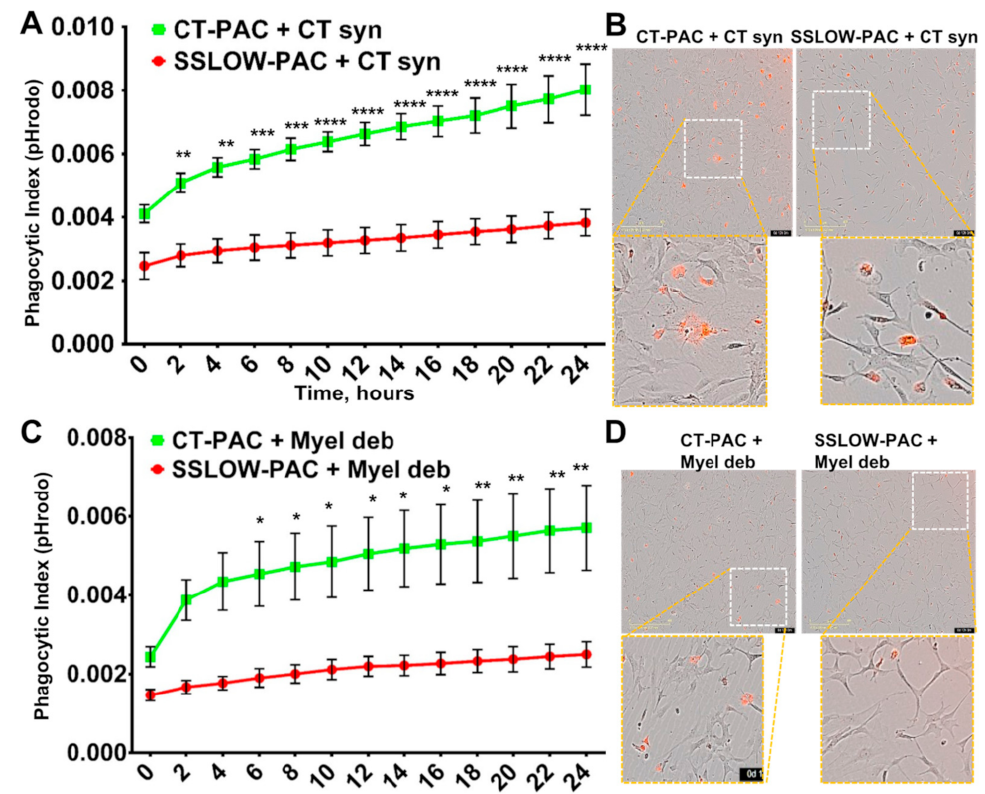
Figure 7. Live-cell imaging of phagocytic activity of PACs from SSLOW-infected mice. ( A ) Real-time, live-cell imaging of uptake of CT-syn by SSLOW-PACs or CT-PACs monitored by pHrodo Red fluorescence assay over the time period of 24 h. ( B ) Representative overlaps of phase-contrast and fluorescence images of SSLOW-PACs and CT-PACs exposed to 22L-syn or CT-syn. ( C ) Real-time, live-cell imaging of uptake of myelin debris by SSLOW-PACs and CT-PACs over the time period of 24 h monitored by pHrodo Red fluorescence assay. ( D ) Representative overlaps of phase-contrast and fluorescence images of SSLOW-PACs and CT-PACs exposed to myelin debris. For all live-cell imaging assays, n = 3 SSLOW-PAC or CT-PAC cultures, each isolated from an individual animal and cultured in three wells. For each well, four images were automatically acquired every 2 h. n = 3 independent isolations from individual animals for each CT-syn or myelin debris. Data presented as mean ± SEM. * p ≤ 0.05, ** p ≤ 0.01, *** p ≤ 0.001, and **** p ≤ 0.0001 by a two-way ANOVA followed by Tukey’s